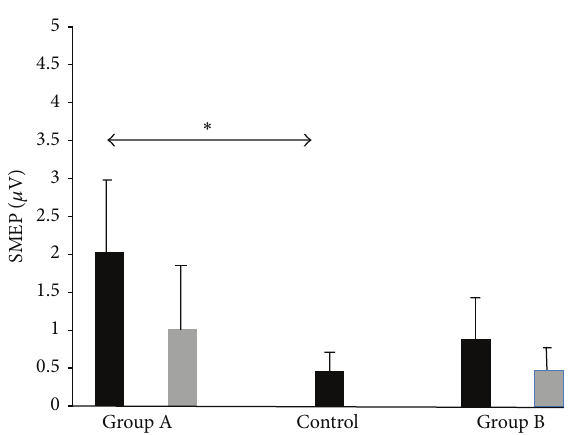
Figure 1: sMEP findings graphically. Asterisks denote statistical significance. Preoperative bars are black and postoperative bars are grey. sMEP, sum of MEP amplitudes in mV in vertical axis. Horizontal axis depicts patient and control groups.